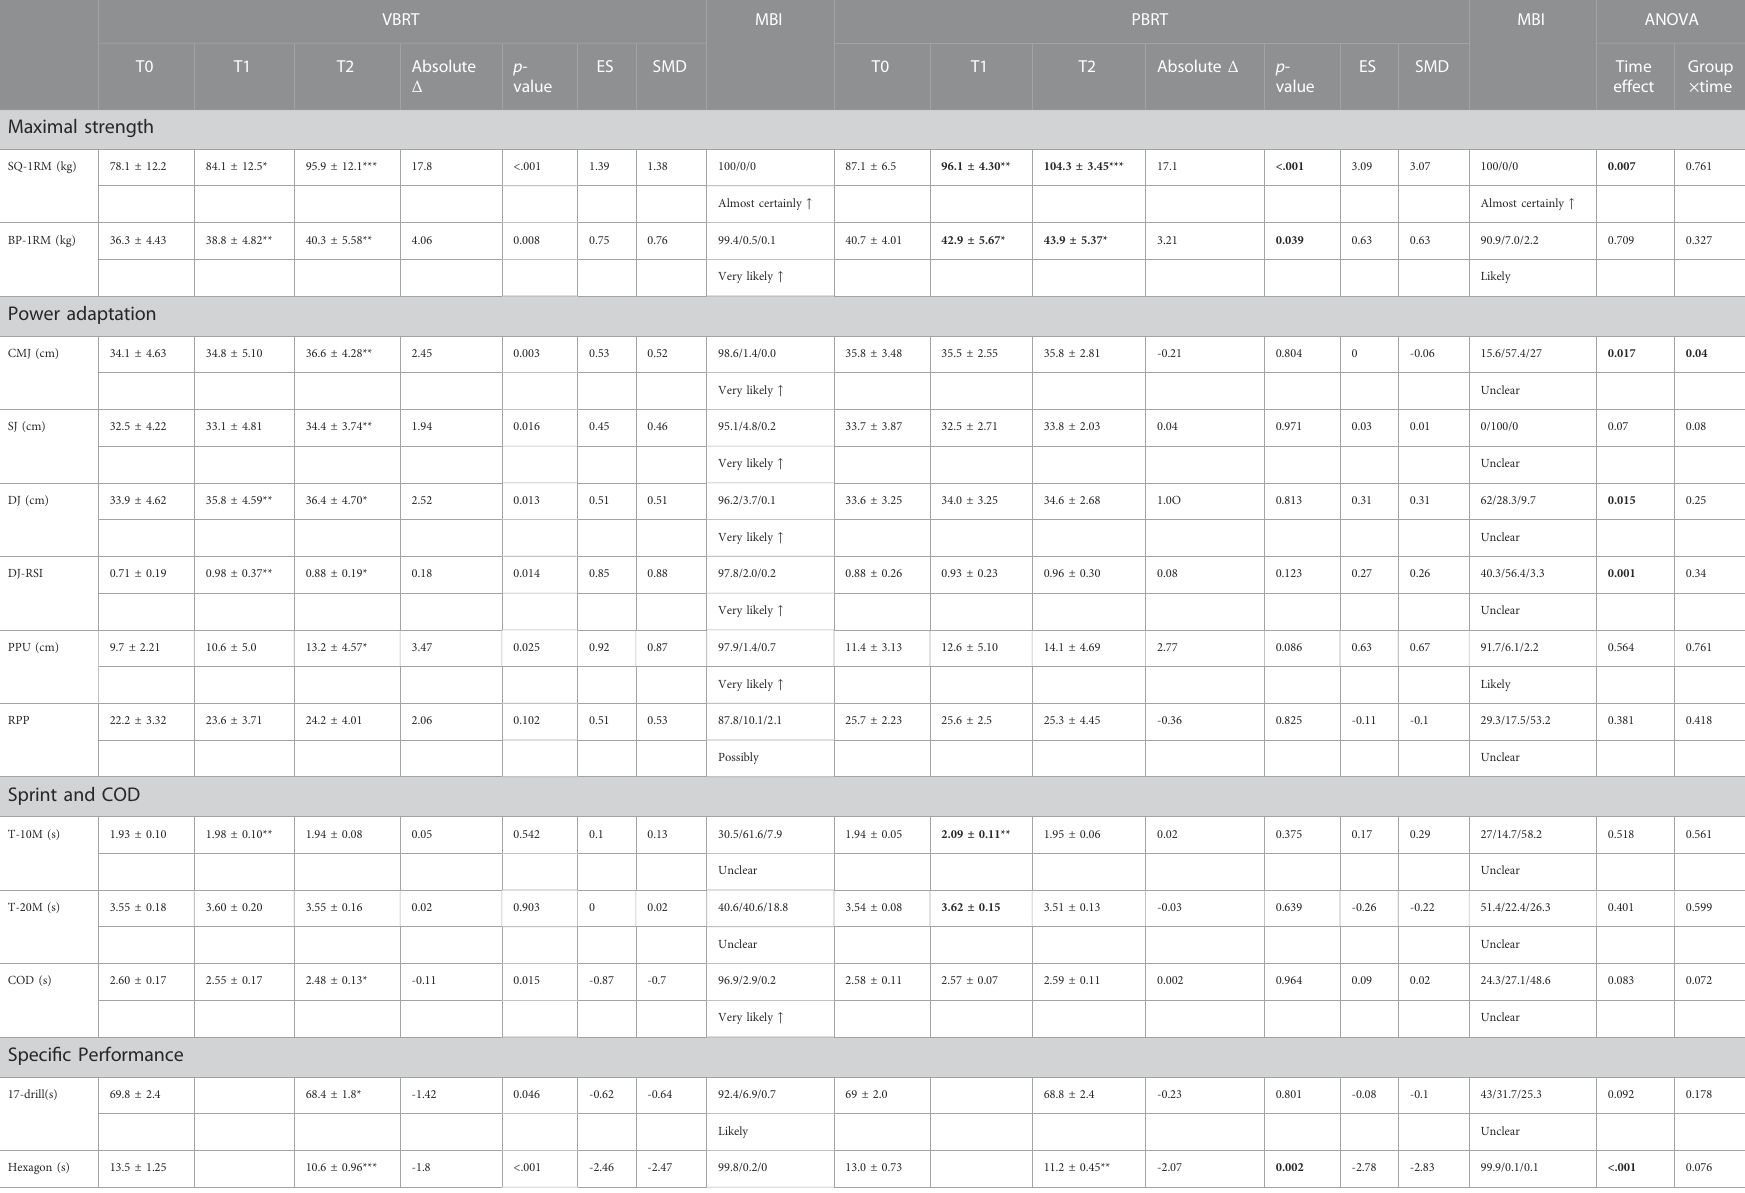
TABLE 3 Effects of the interventions on athletic performance (muscle strength/power and speci fi c